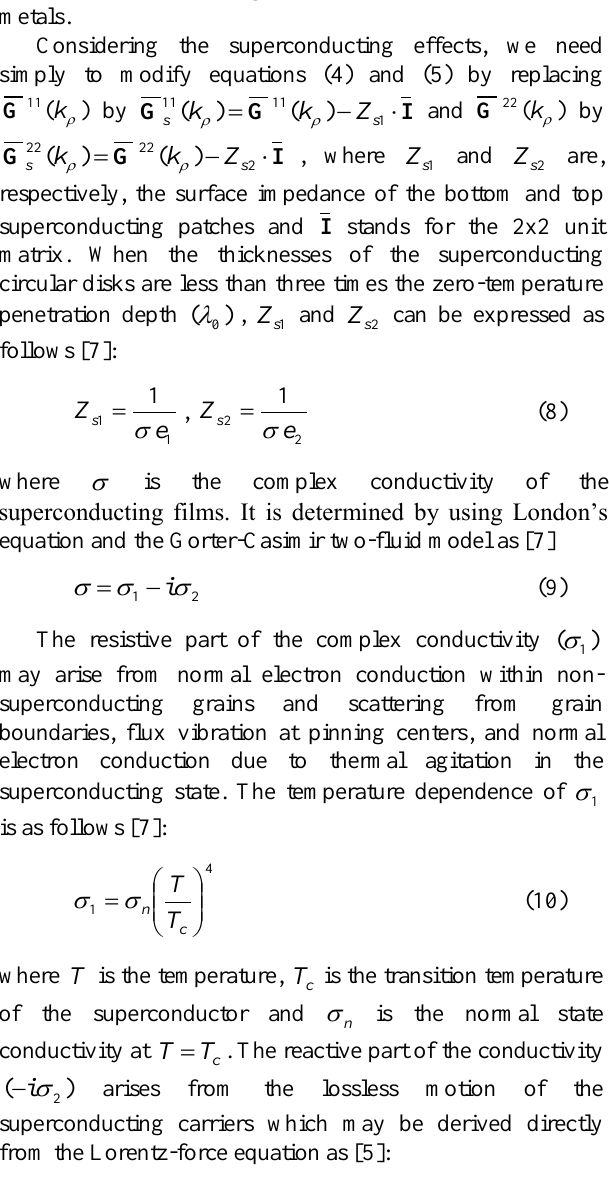
Table 1: Comparison of our calculated resonant frequencies with those obtained via the modified cavity model of Richard et al.